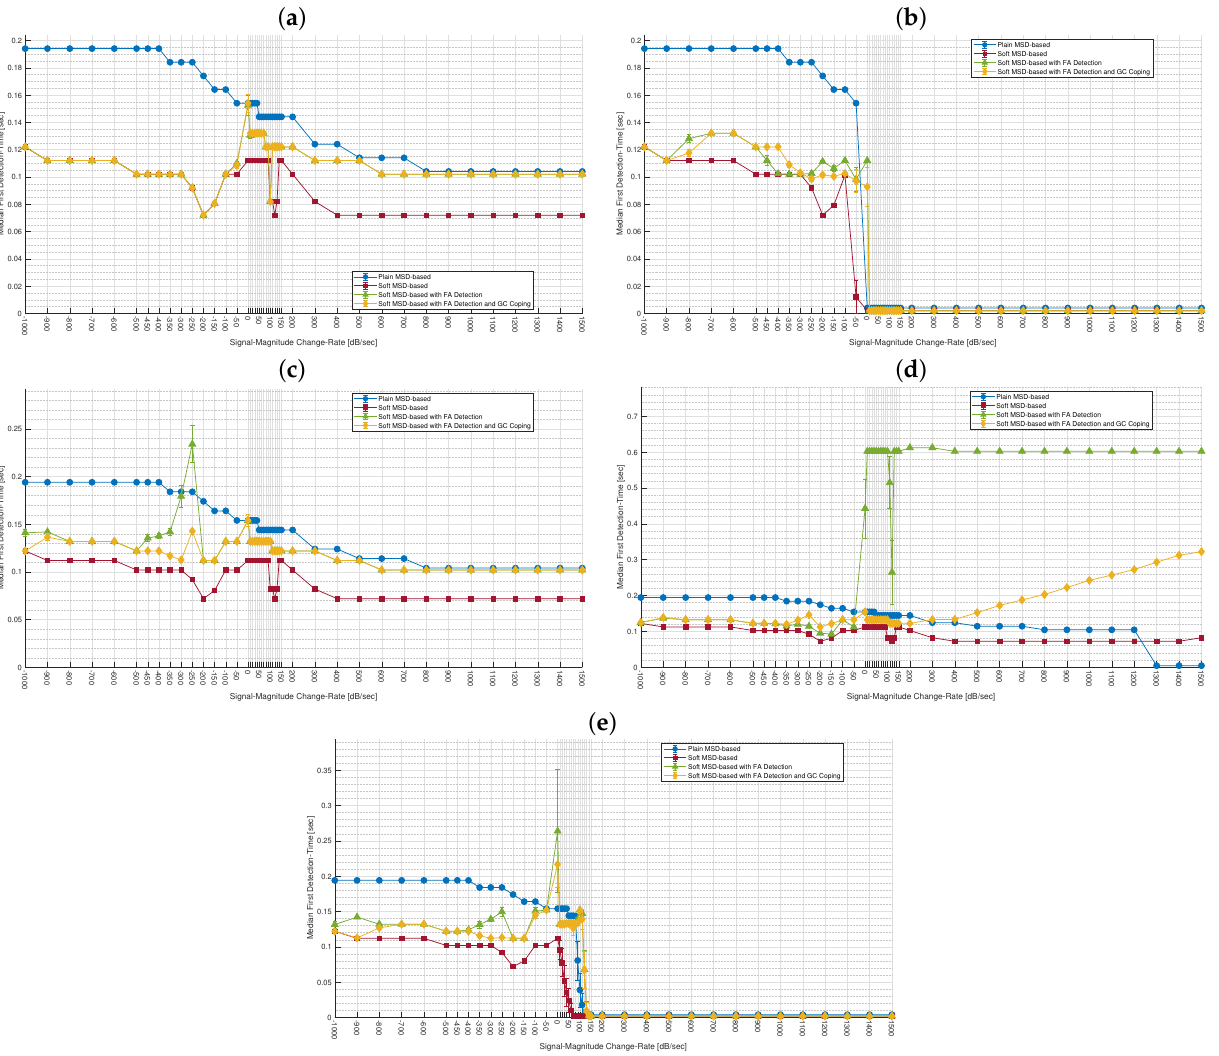
Figure 6. Response time distributions over the set of howling change-rate configurations, for each howling scenarios: ( a ) Impulse Response Howl; ( b ) Speech Howl; ( c ) Full Stability Gain-Control Howl; ( d ) Recovery Gain-Control Howl; ( e ) Increasing Gain-Control Howl. The (median) first howling detection time, relative to the energy burst, is depicted by the mean value and its 90% confidence-interval, when averaged over the set of pole